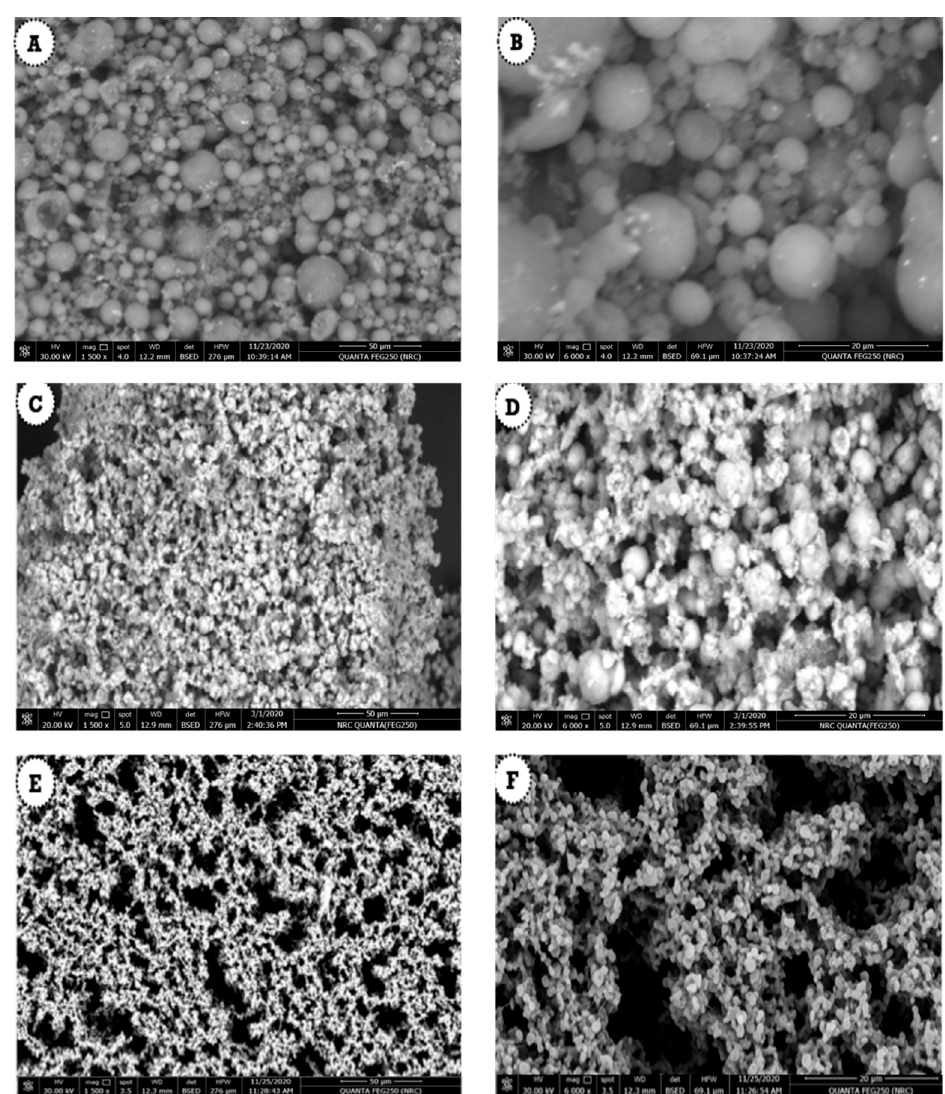
Figure 4. Scanning electron microscope images of anise oil-based nanoemulsions using ( A , B ) 5.5 mL, ( C , D ) 9.5 mL and ( E , F ) 13.5 mL of anise oil.